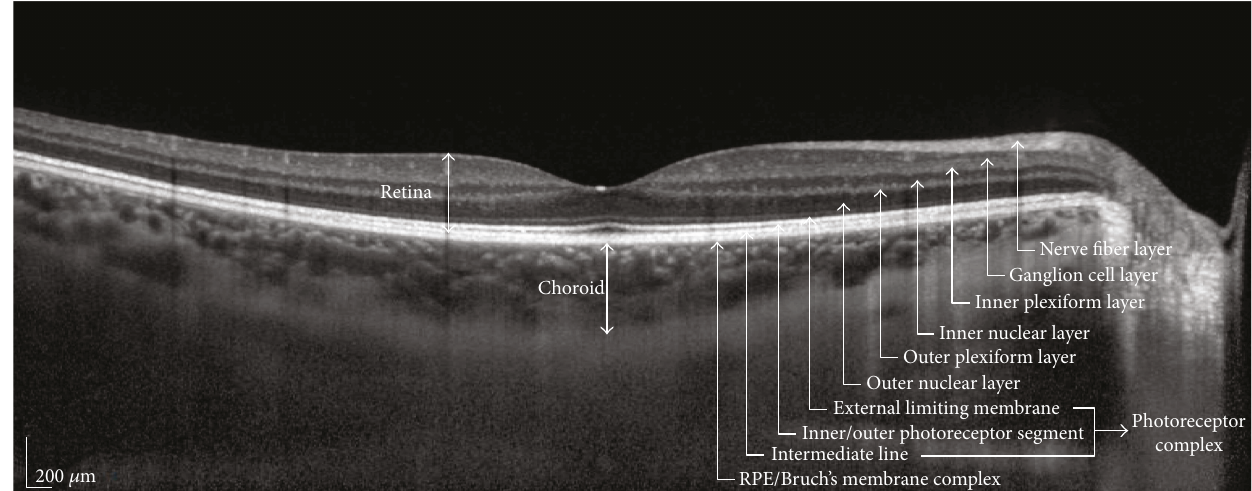
Figure 2: Optical coherence tomography scan showing the retinal layers and the macular choroidal thickness in a normal eye.